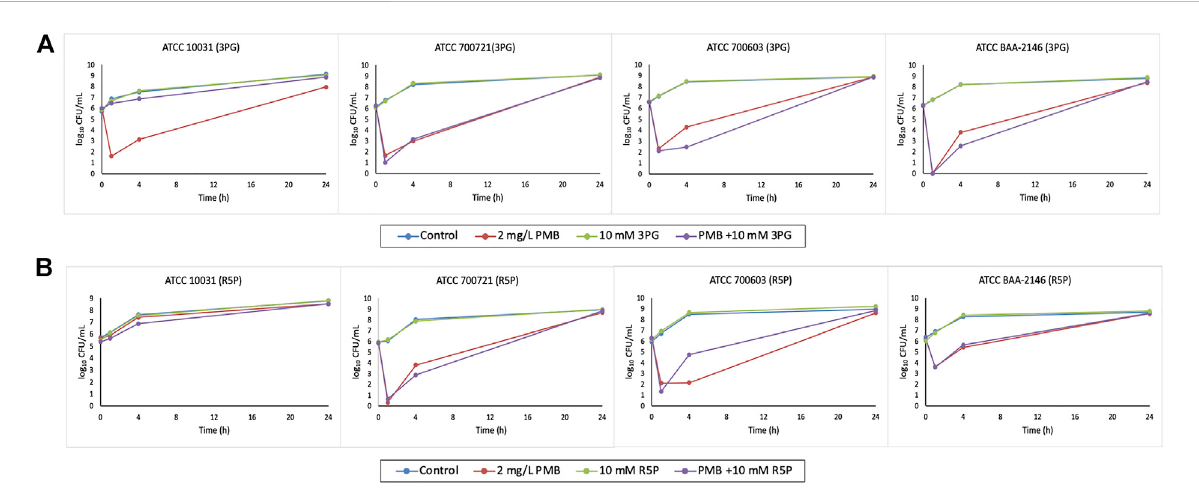
FIGURE 3 Time – kill curves of metabolite treatment with polymyxin B (PMB), alone and in combination. (A) 10 mM 3PG and (B) 10 mM